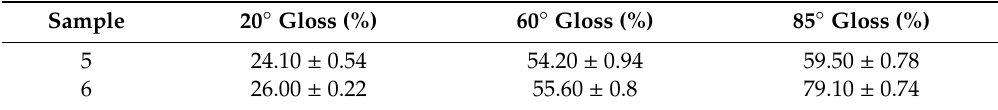
Table 9. The gloss change of waterborne coating on Chinese fir.